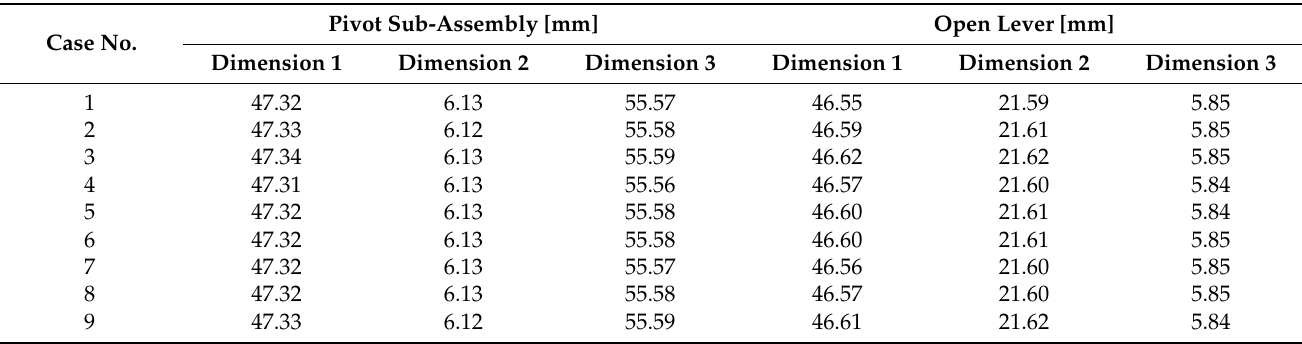
Table 12. Results of key dimensions.